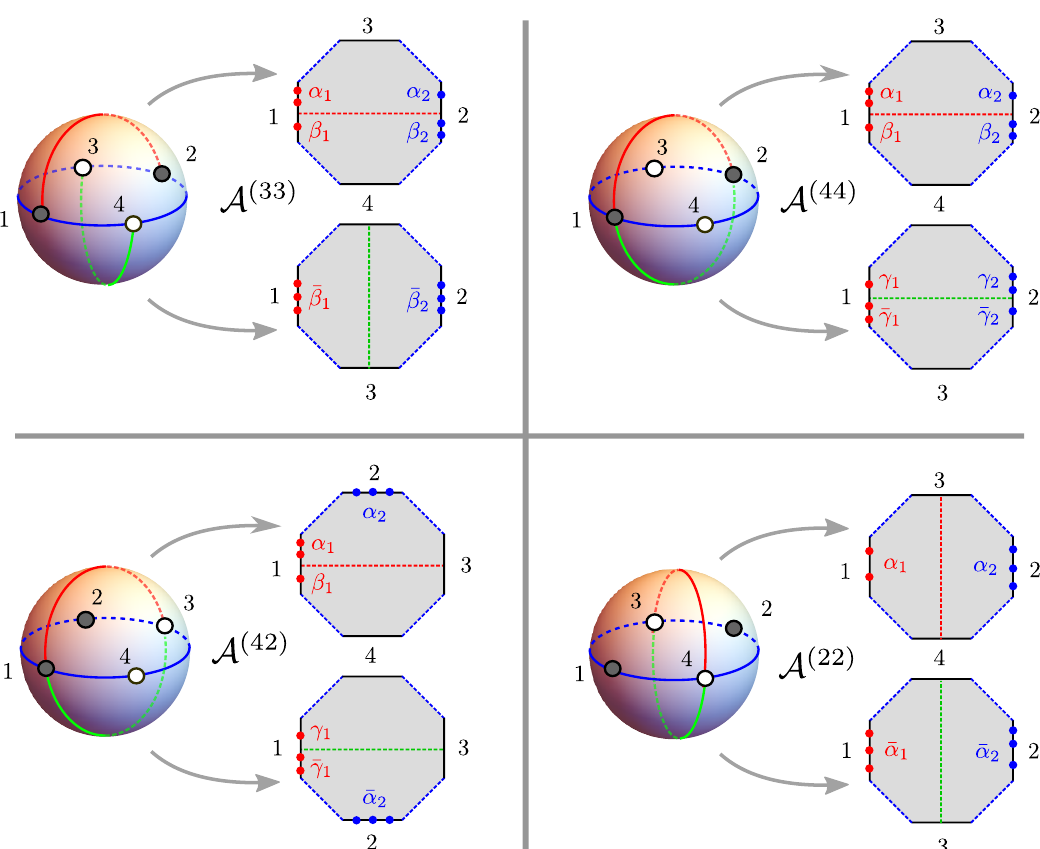
Figure 3 . Four tessellations of the sphere into hexagons. The four-point function of two non- protected operators at positions 1 ; 2 (dark dots) and two 1 -BPS ones (white dots) is depicted on 2 the sphere. Strands of ‘ ij propagators are denoted as lines connecting points i and j . Planarly, only six set of \edge-widths" ‘ ij can be non vanishing; this gives the four topologies of the picture. For each of them, we (cid:12)nd an hexagon tessellation by cutting the sphere along the edges with ‘ ij > 0. We denote the corresponding hexagon amplitudes as A ( kl ) to highlight that operator 1 has been cut into k pieces and operator 2 into l pieces. As always, the computation of A ( kl ) requires